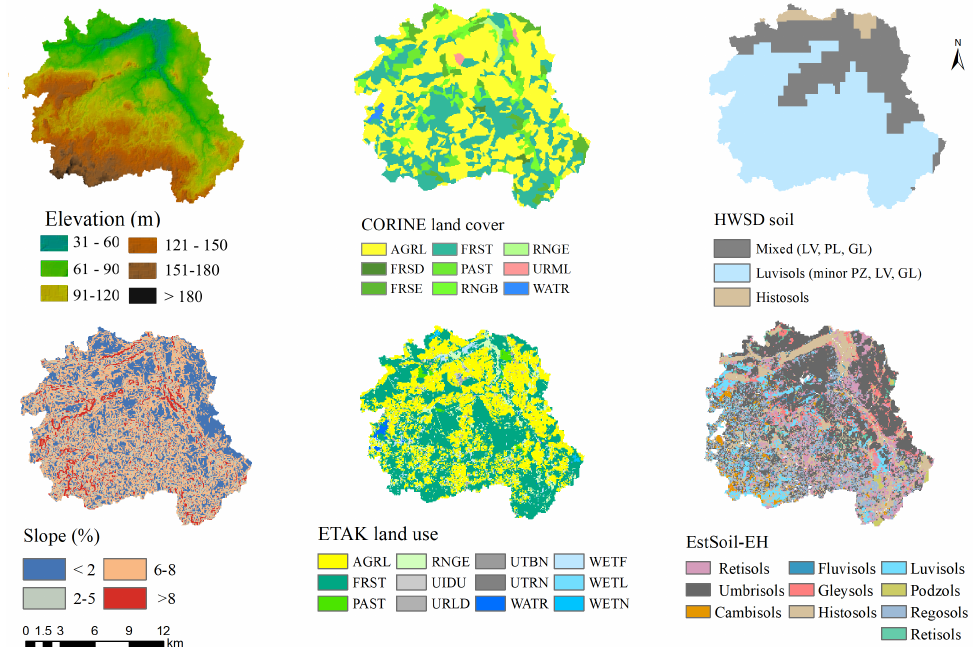
Figure 2. Spatial distribution of SWAT input data. Table 1. The ETAK and CORINE land cover types reclassified into SWAT classes and their proportion in the Porijõgi